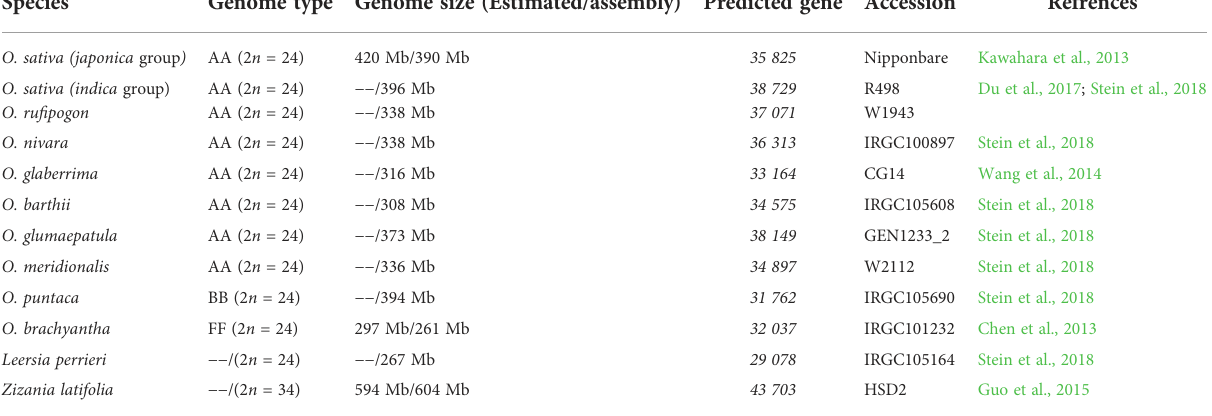
TABLE 5 List of sequenced genomes of rice and its relatives. Species Genome type Genome size (Estimated/assembly) Predicted gene